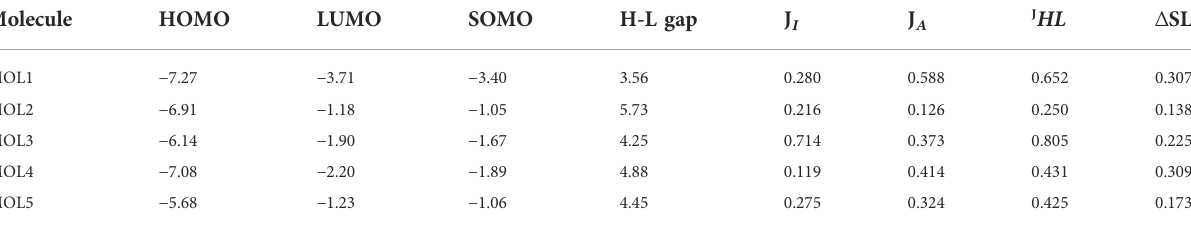
TABLE 5 Frontier orbital energies, HOMO-LUMO gap and the KID descriptors for the studied molecules (all in eV). Molecule HOMO